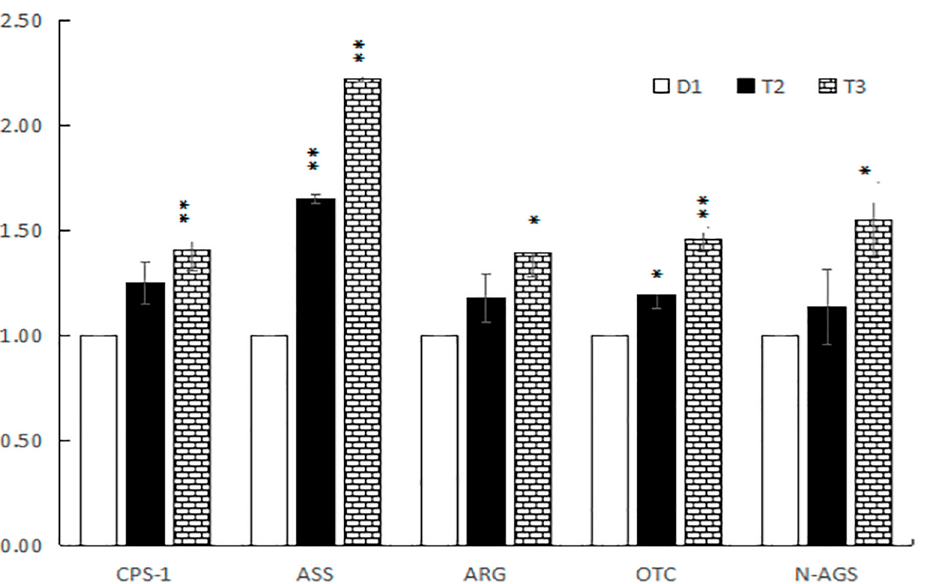
Figure 1. The relative expression levels of CPS-1, ASS, ARG, OTC, and N-AGS mRNA in liver. Con- trol group (D1), low protein with low RPAA (T2), and low protein with high RPAA (T3). CPS-1 = Carbamoyl-phosphate synthase 1; ASS = Argininosuccinate synthase; ARG = Arginase; OTC = Ornithine carbamoyltransferase; N-AGS = N-acetylglutamate synthase. *: The difference is significant. **: The difference is extremely significant.